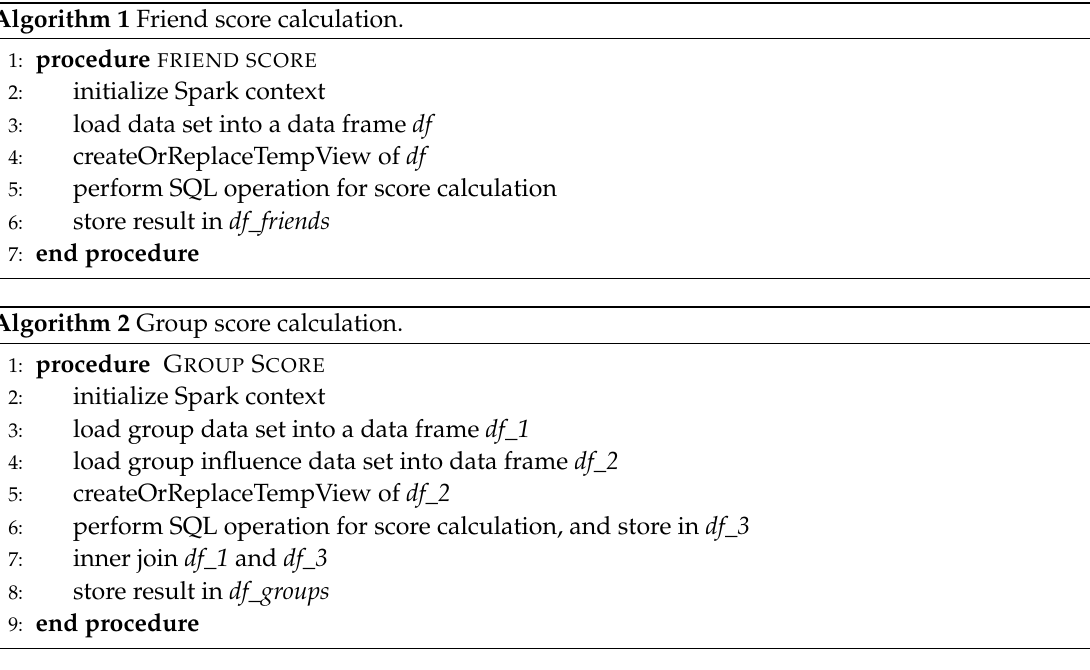
Table 9. Score calculation for each